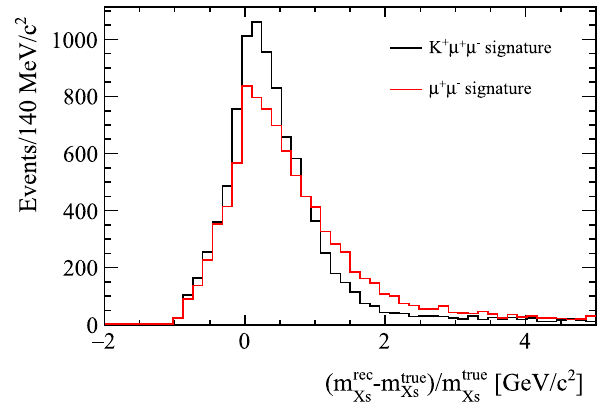
Fig. 2 Resolution on the invariant mass of the strange hadron, m X comparing when only the two leptons are reconstructed and when an additional kaon is reconstructed for B + → ( K 1 ( 1270 ) +